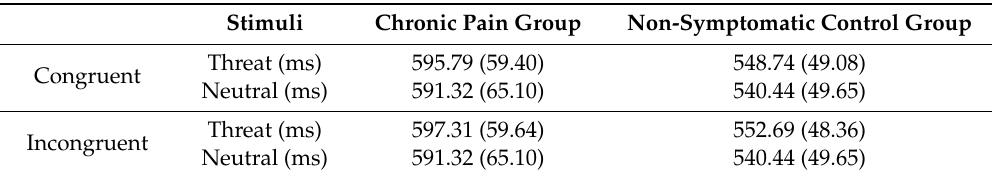
Table 2. Mean reaction times of congruent and incongruent trials (in ms; standard deviations in brackets) for the threat and neutral images in the dot probe task for participants with chronic low back pain and the non-symptomatic control